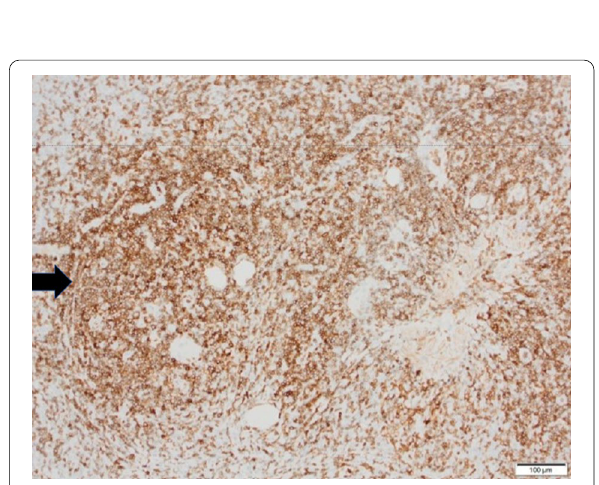
Fig. 4 Immuno‑histochemical staining negative for CD 5